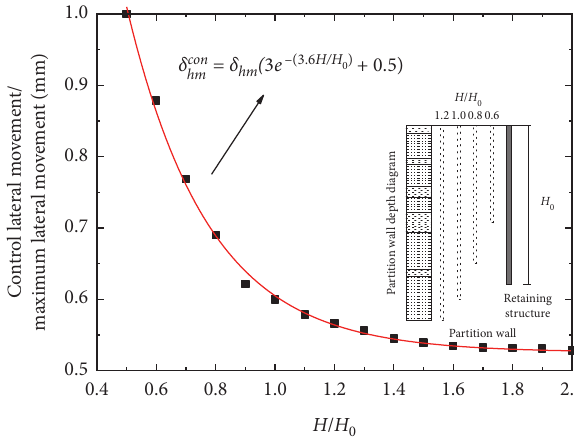
Figure 12: Relation curve between δ con